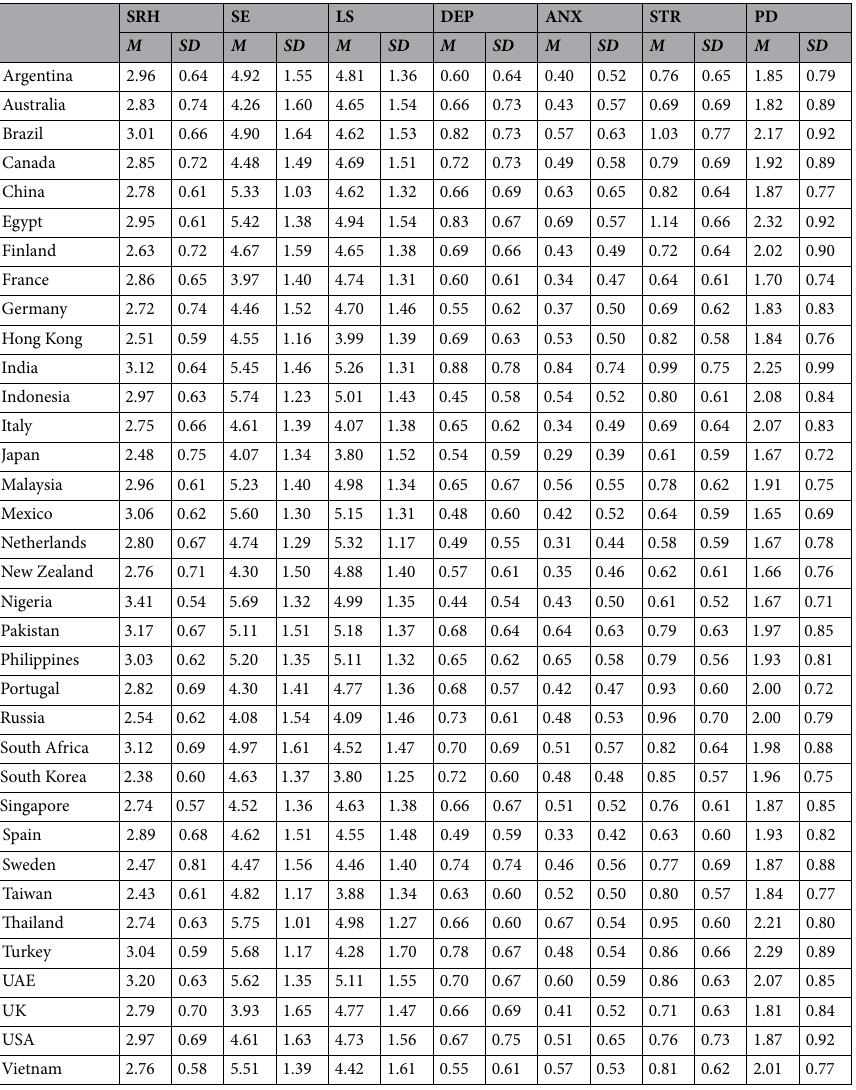
Table 1. Descriptive statistics for mental well-being indicators across countries/societies. SRH self-rated health, SE self-esteem, LS life satisfaction, DEP depression, ANX anxiety, STR stress, PD psychological